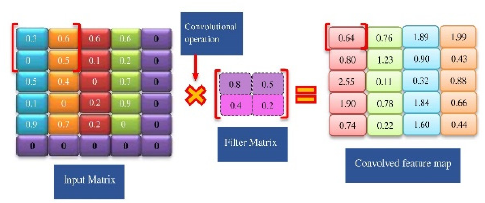
Figure 6. Convolution of the input and filter matrices.